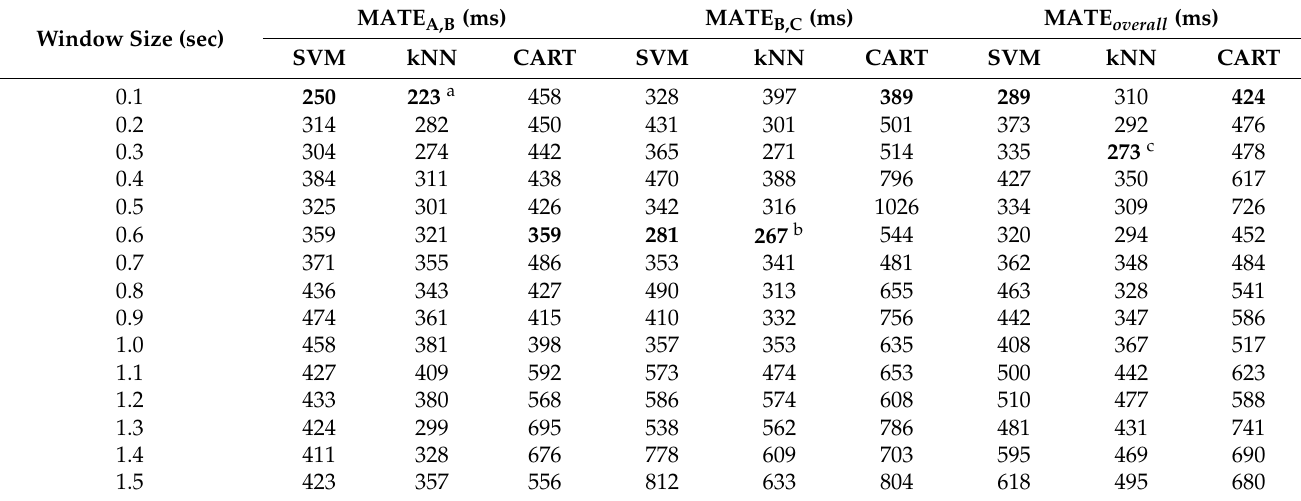
Table 9. The MATE A,B , MATE B,C and MATE overall of healthy subject using different machine learning models vs. difference window sizes (s).